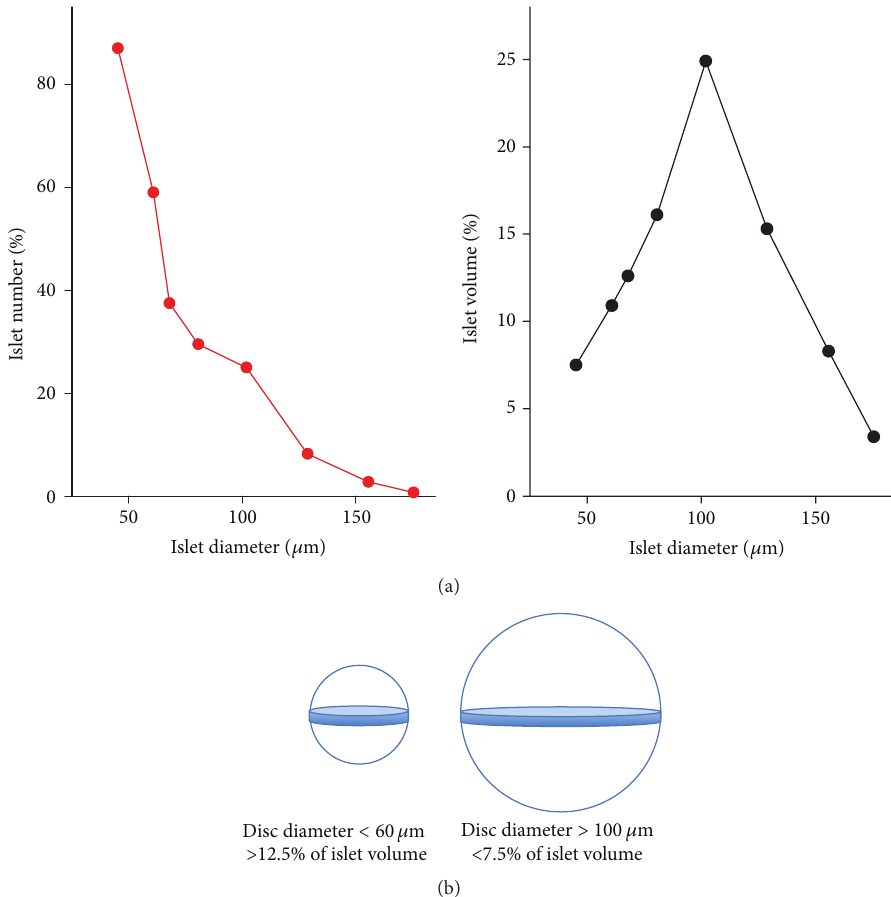
Figure 1: (a) Relations between islet diameter and the number (left panel) and total volume (right panel) of mouse islets. Redrawn from